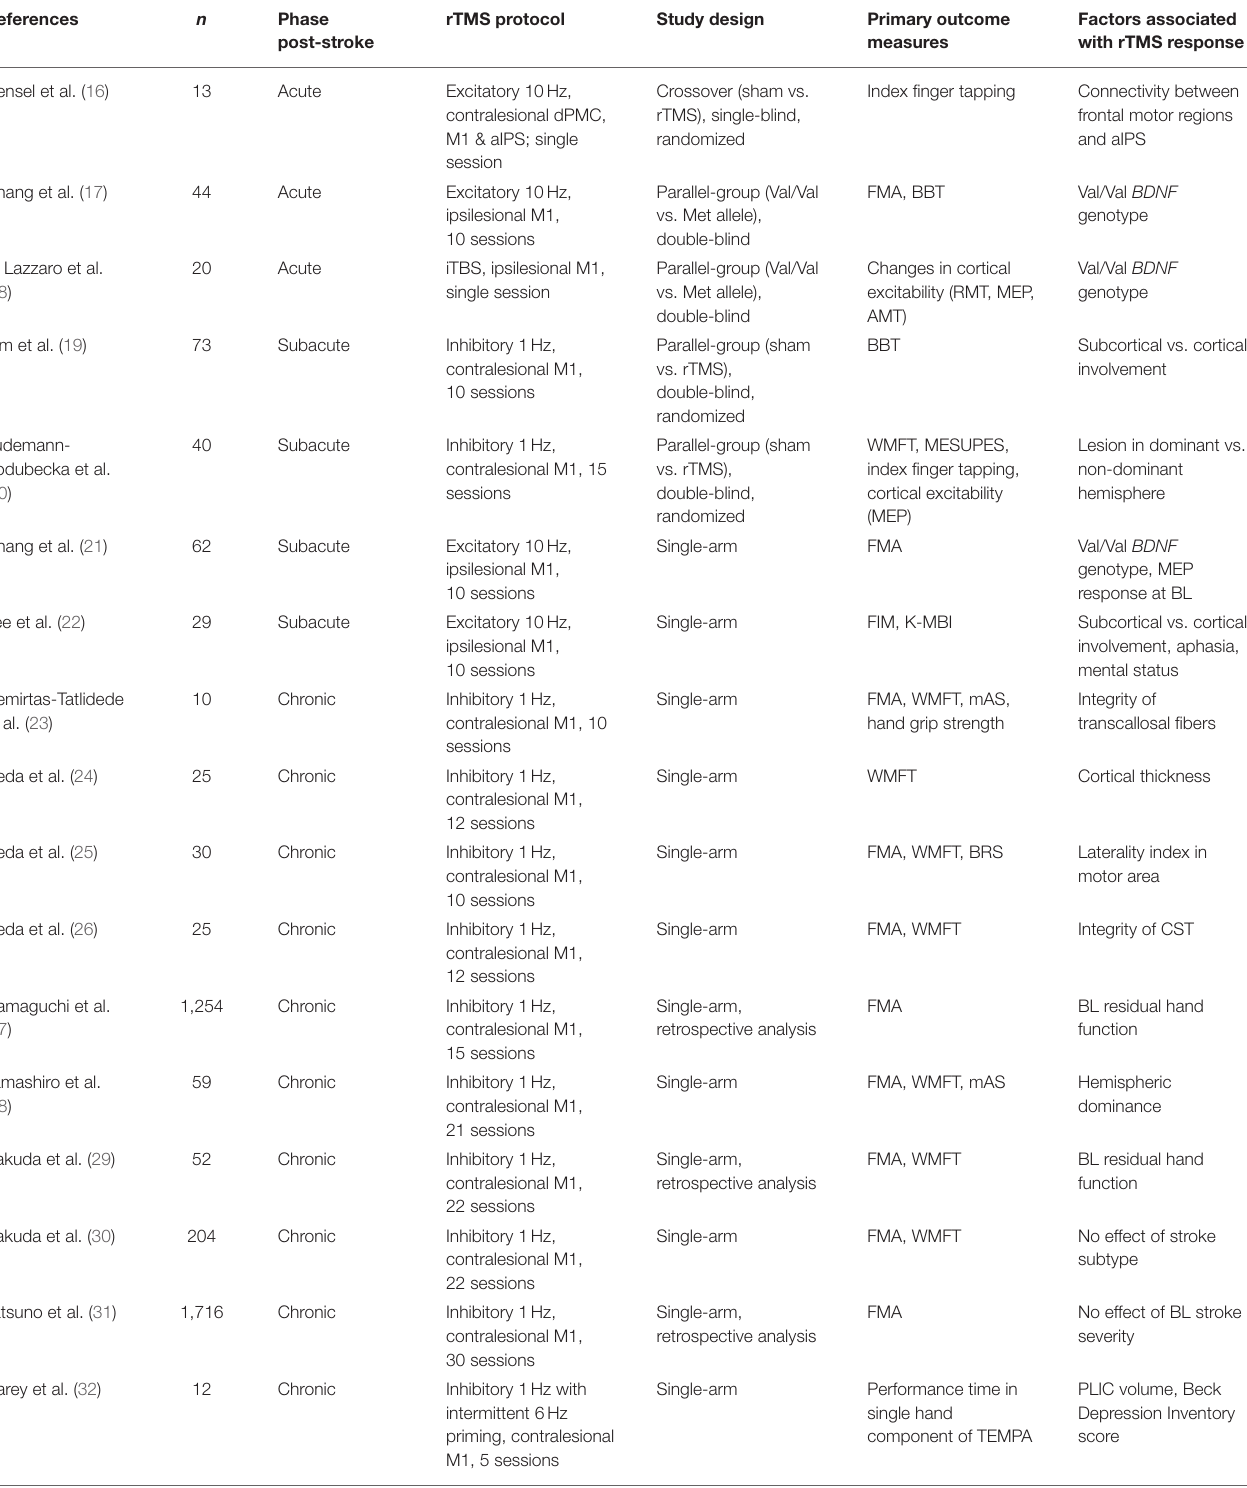
TABLE 1 | Overview of studies included in this